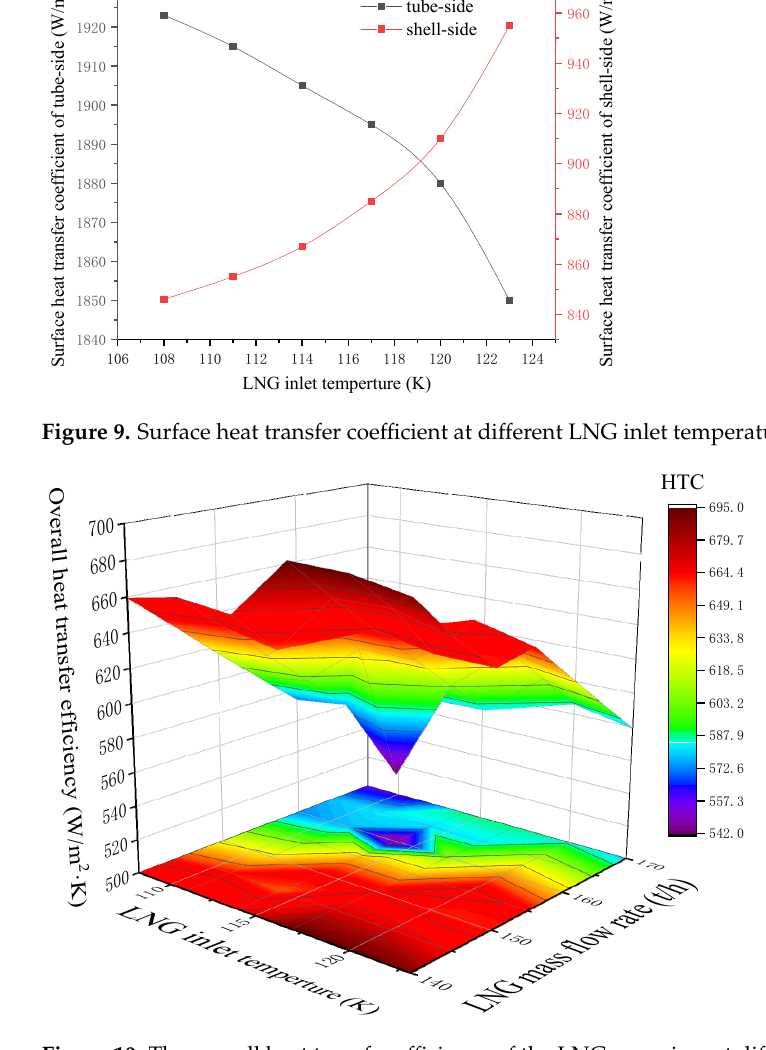
Figure 10. The overall heat transfer efficiency of the LNG vaporizer at different LNG flow rates and LNG temperatures.